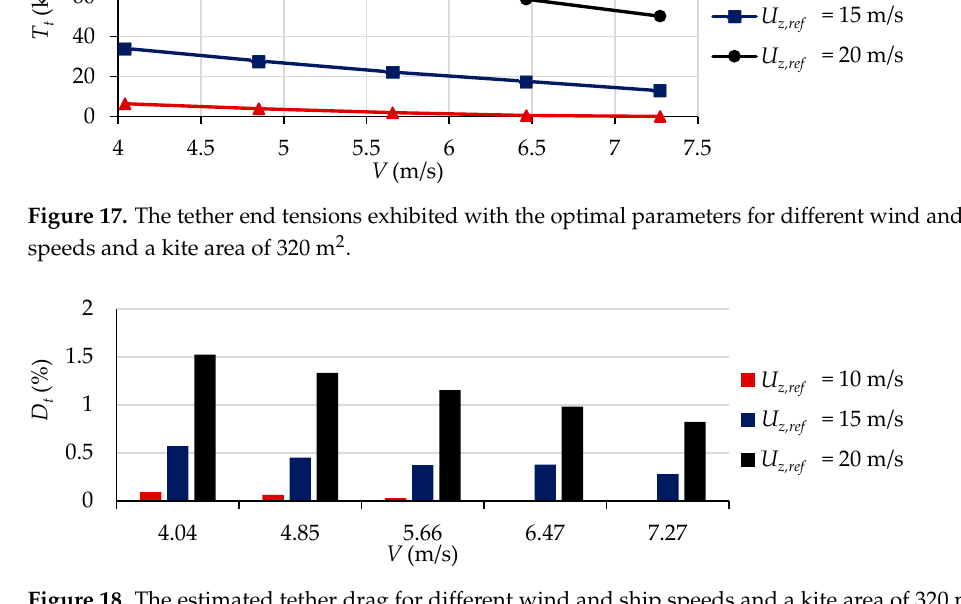
Figure 18. The estimated tether drag for different wind and ship speeds and a kite area of 320 m 2 as a percentage of the kite thrust for the respective combination of ship and wind